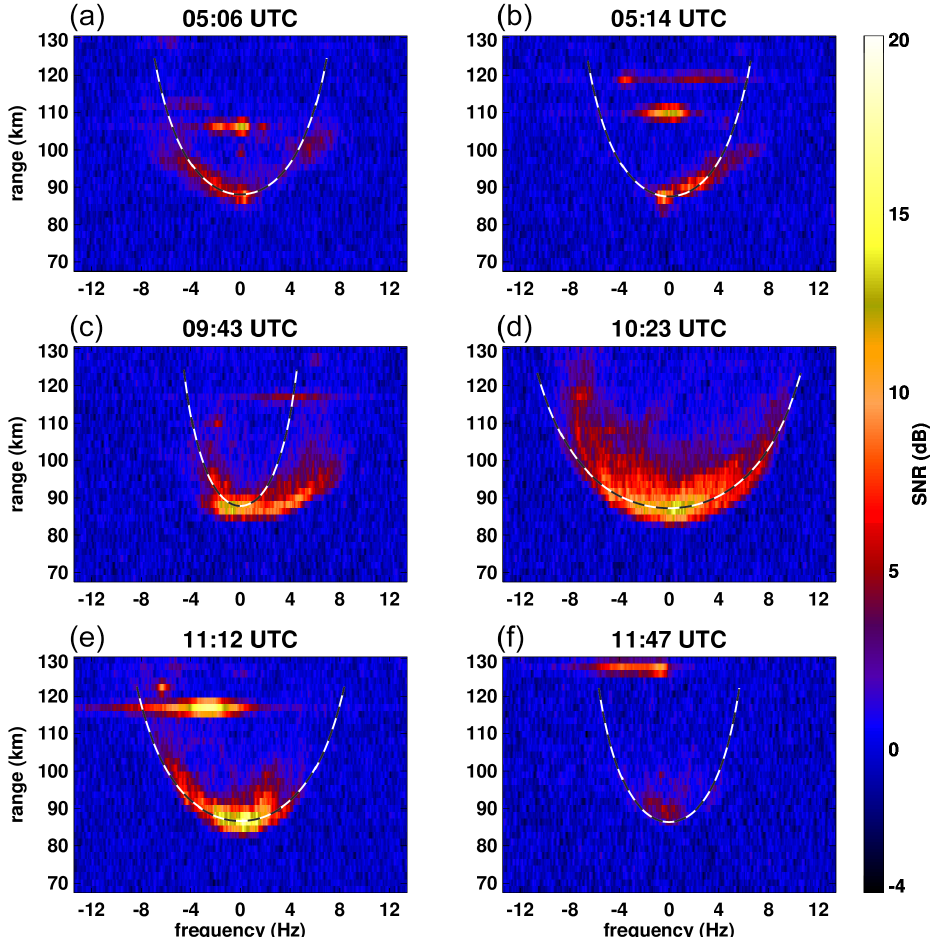
Figure 4. NSMR range–Doppler profiles for 19 July 2020 (0.018Hz frequency resolution), constructed from 1min observation periods. (a) Transient PMSE detection. (b) Asymmetric transient PMSEs. (c) Asymmetric onset of strong PMSE return. (d) Strong PMSE return exhibiting fine structure. (e) End of strong PMSE period displaying asymmetric intensity distribution. (f) End of PMSE detection period primarily around zero Doppler. Dashed lines show the expected range–Doppler profile of a thin layer, based on speed calculated from meteor trail detection radial